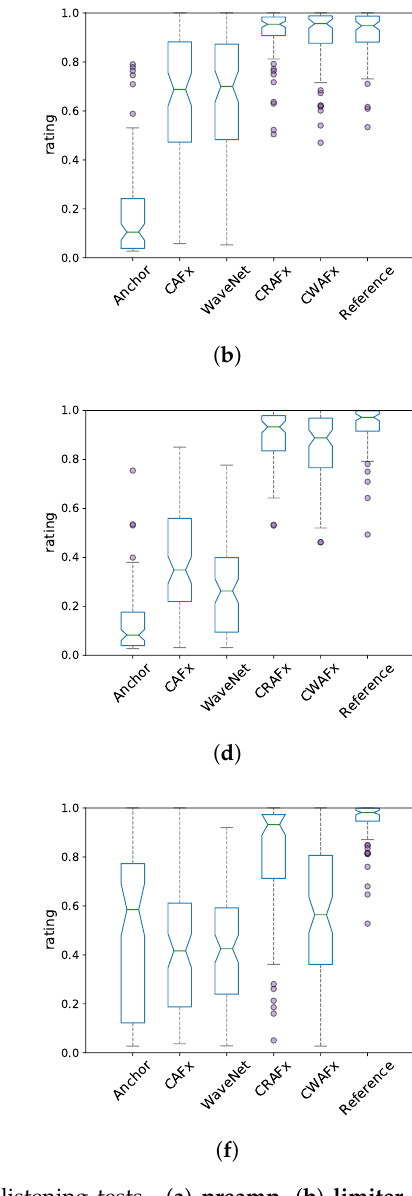
Figure 6. Box plot showing the rating results of the listening tests. ( a ) preamp , ( b ) limiter , ( c ) Leslie speaker horn-tremolo , ( d ) Leslie speaker woofer-tremolo , ( e ) Leslie speaker horn-chorale and ( f ) Leslie speaker woofer-chorale